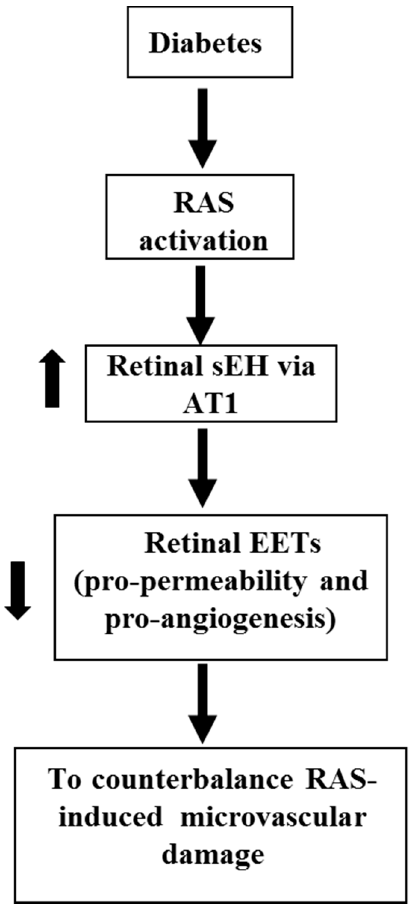
Figure 5. ThehypothesisabouttheinteractionofsEH / EETsandRASinDR.Duringdiabetes,RASactivation Figure 5. The hypothesis about the interaction of sEH/EETs and RAS in DR. During diabetes, RAS augments retinal sEH, via AT1, which decreases EETs (pro-permeability and pro-angiogenesis factors) activation augments retinal sEH, via AT1, which decreases EETs (pro-permeability and pro- to counterbalance the e ff ects of RAS on retinal microvascular angiogenesis factors) to counterbalance the effects of RAS on retinal microvascular damage.